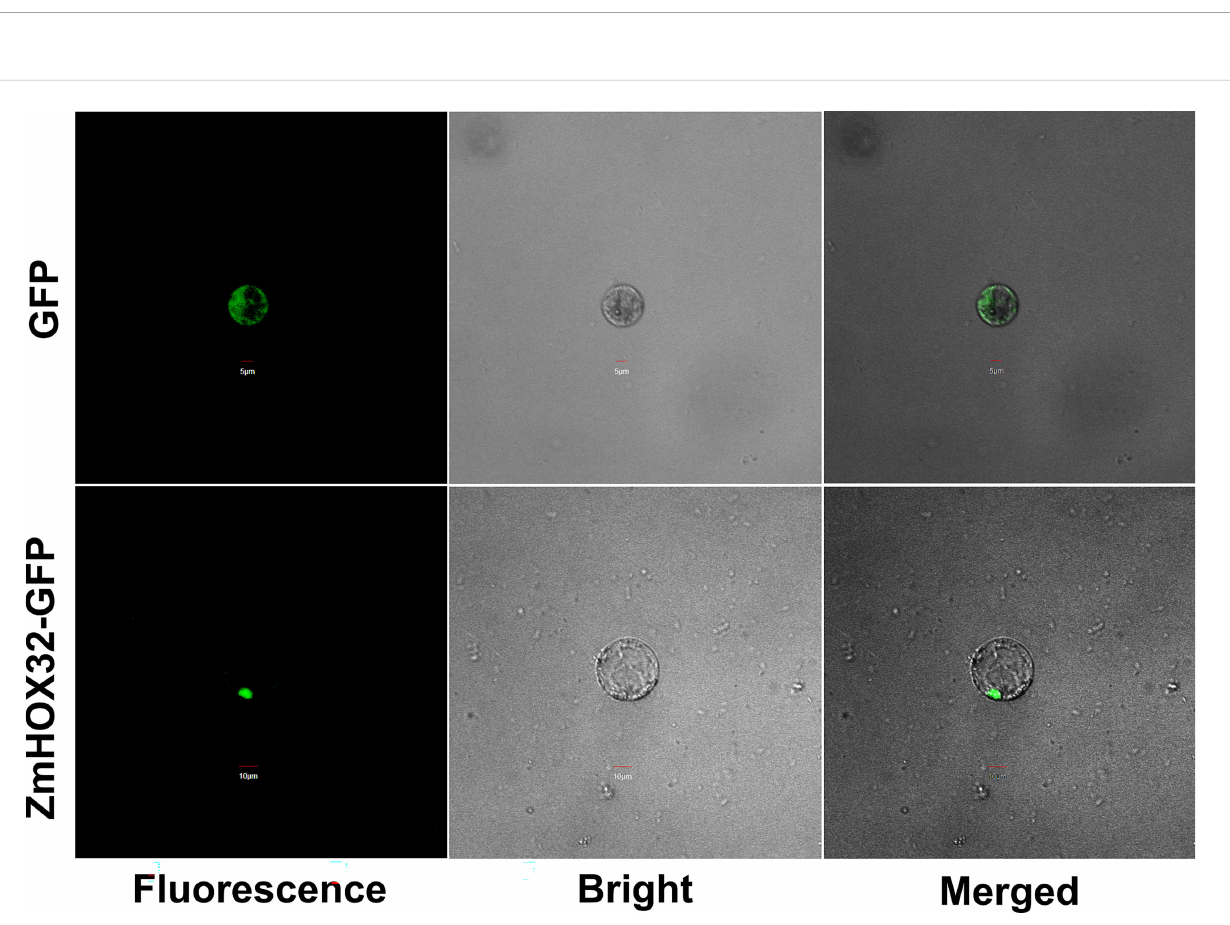
FIGURE 2 Subcellular localization of the HOX32 protein in maize. Subcellular localization of 35S::GFP and 35S::ZmHOX32-GFP in maize protoplasts; maize protoplast cells were used for taking images of green fl uorescence, chloroplast auto fl uorescence, visible light, and merged visible light.